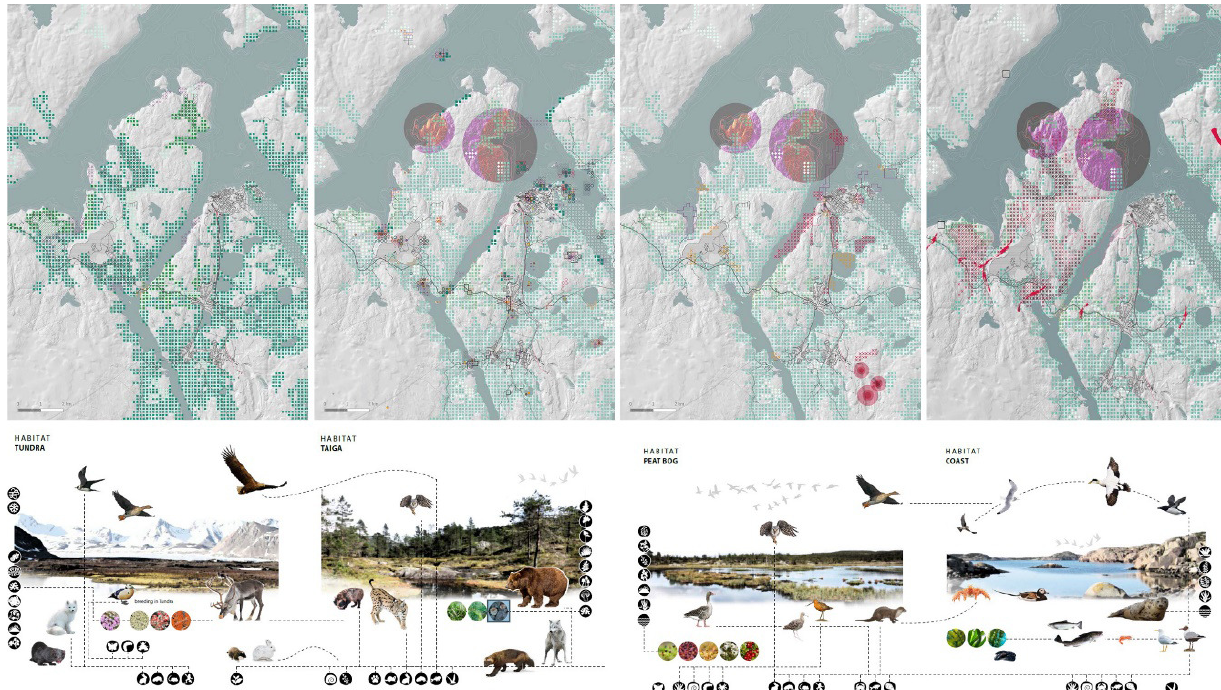
Figure 2. Series of maps overlapping different ecological territories with the friction area of the proposed port develop‐ ment by the municipality. Source: Höller